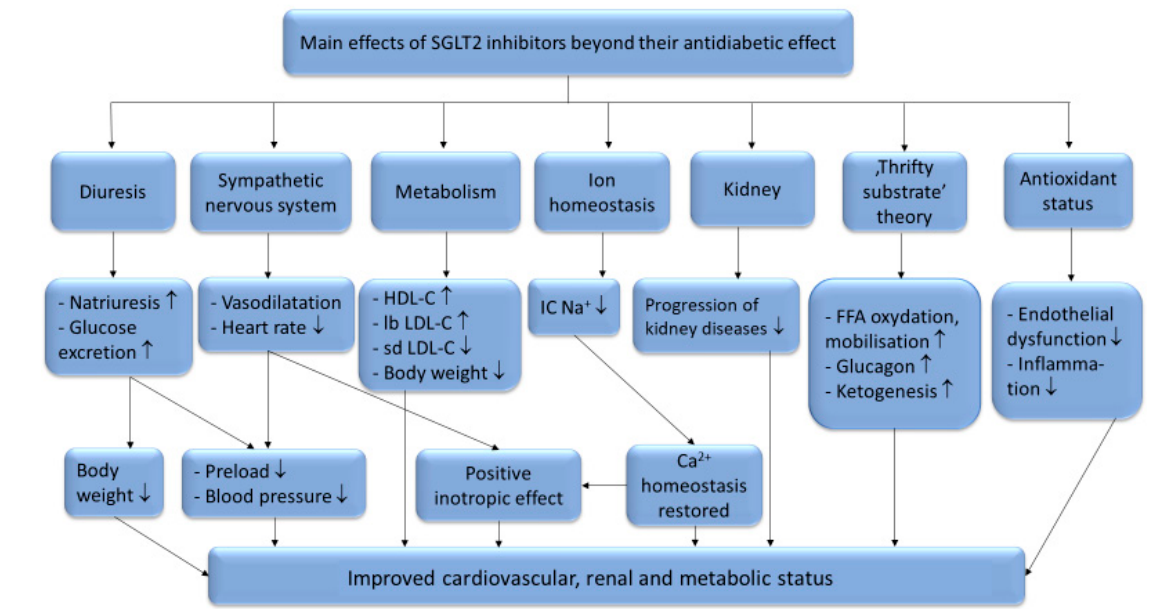
Figure 1. The systematic effects of SGLT2-inhibitors. HDL-C: high-density lipoprotein cholesterol; lb LDL-C: large buoyant low-density lipoprotein cholesterol; sd LDL-C: small dense low-density lipoprotein cholesterol; TG: triglycerides; IC Na + : intracellular sodium-ion; FFA: free fatty acids; ↑: increased amount; ↓ : decreased amount.